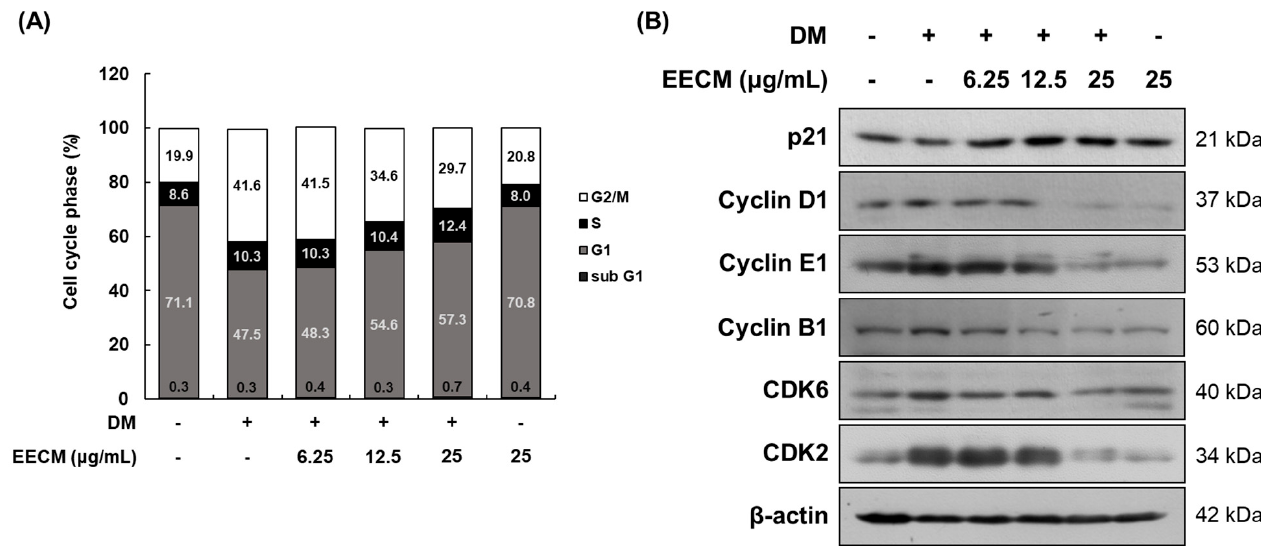
Figure 3. Regulatory effect of EECM on the MCE in 3T3-L1 cells. Differentiated cells were treated